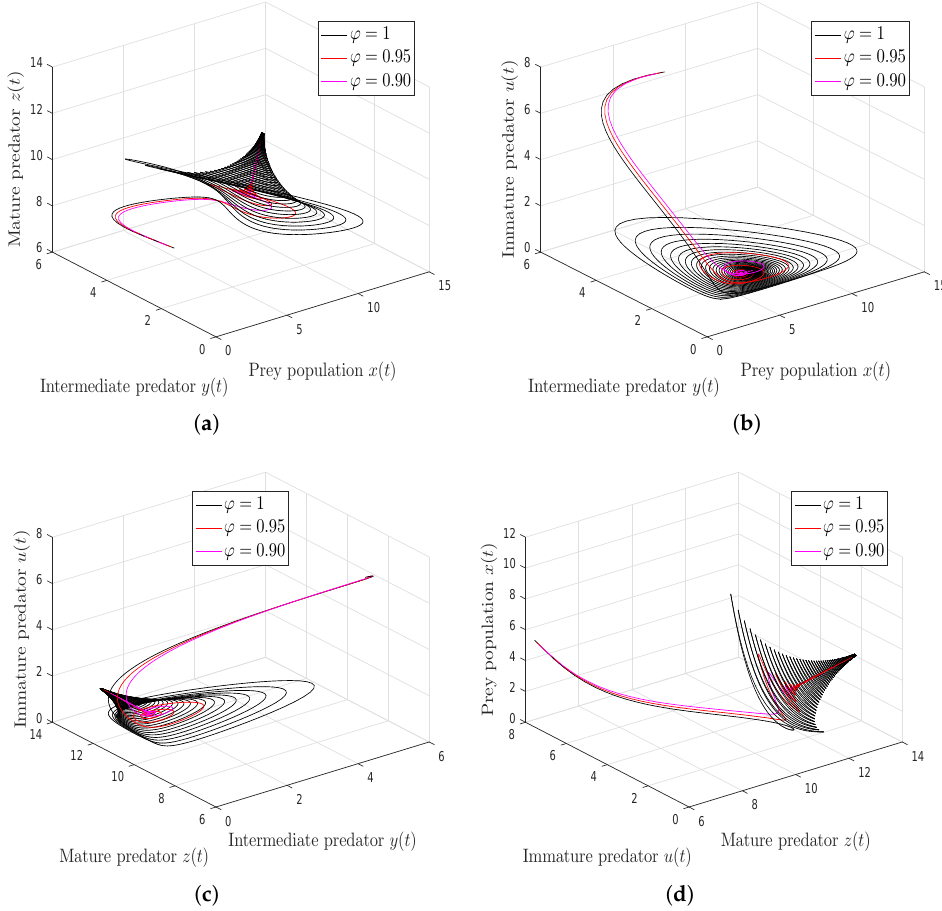
Figure 7. Three-dimensional chaotic phase plot for food web mathematical System (13) with general- ized Caputo fractional operator when ρ =